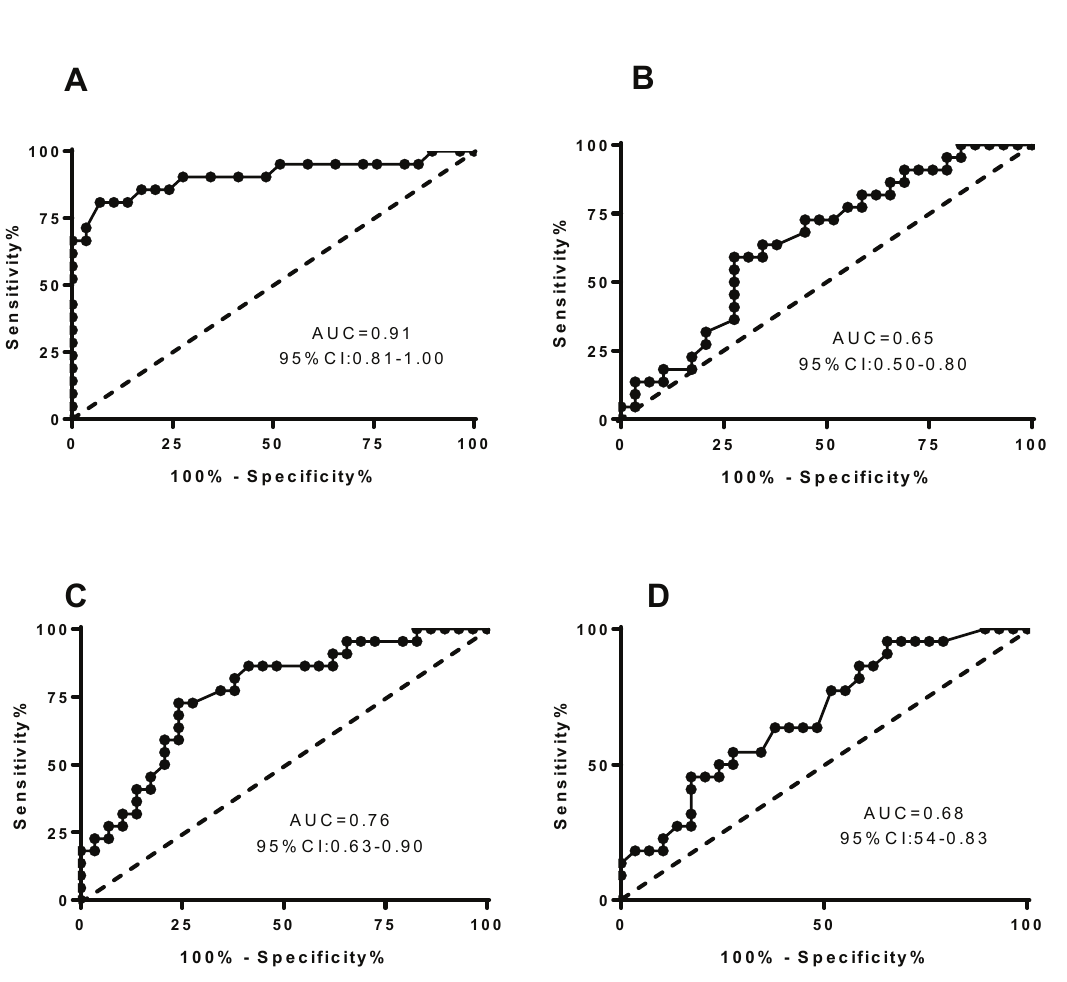
Figure 3 : The roc curve of Serum PCT, CRP and ESR as biomarker in differentiation mild/moderate and severe UC (A: serum PCT; B: serum CRP; C: serum ESR; D: serum folic